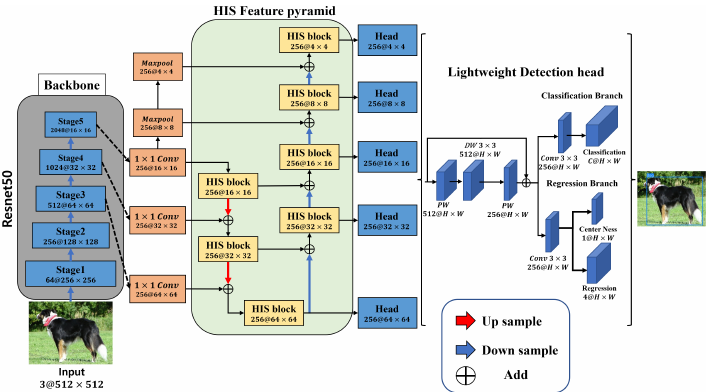
Figure 4. Proposed method architecture We reduced feature loss by rebuilding the feature pyramid on the basis of the proposed block. In addition, the increase in computational cost is minimized through the proposed detection head. Normalization and activation layers are omitted for simplicity.